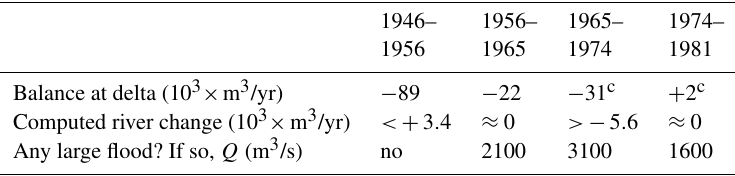
Table 8. Comparison of Table 1 and the differences in Table 7, for the balance at the delta and the change in sediment yield. Flood discharges come from Sect.